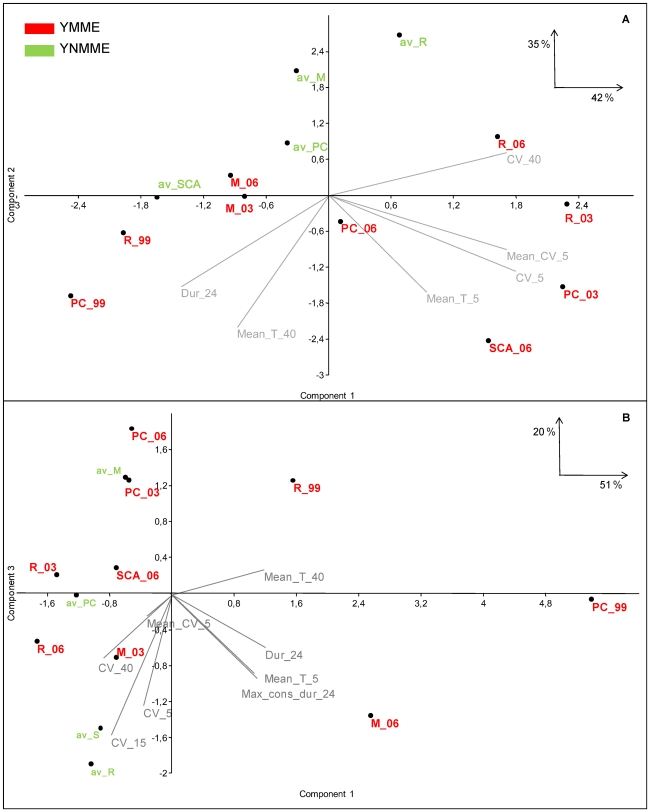
Principal Component Analysis representation.Representation of the first two axes of the Principal Component Analysis using T data from 10 (a) and 25 m depths (b). Two first axes were retained at both depths, accounting for 77 and 71% of data variability. The original T variables used to perform the analyses are represented in grey. Scandola in 2004 at the 10 m depth was not considered among the Scandola YNMMEs in the PCA because this location and year presented the particularity of reaching high temperatures (but not as high as for YMMEs at this location) with no mortality, so it affected the data ordination when considering all locations together. M: Medes, R: Riou: PC: Port-Cros and S: Scandola.